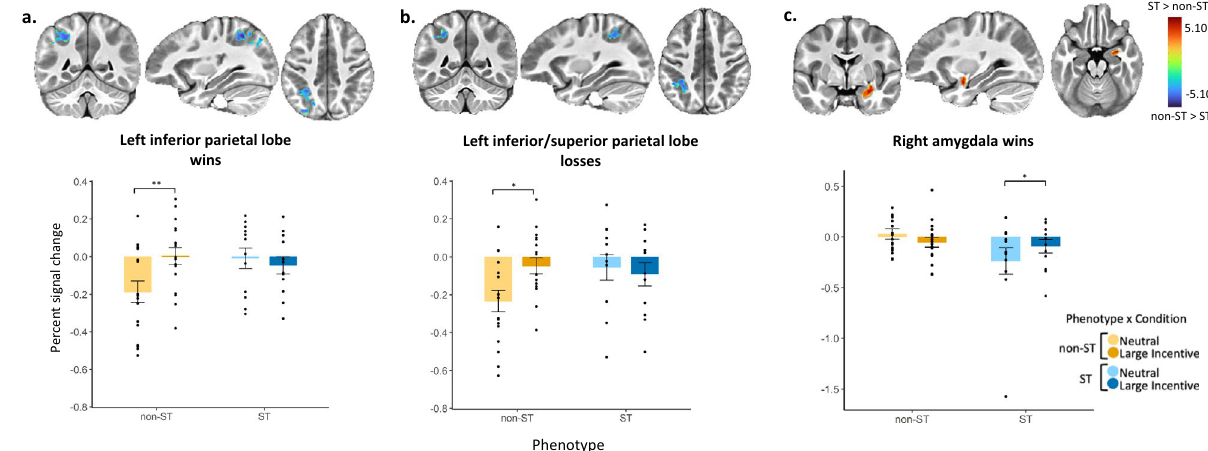
Figure 3. Whole brain voxel-wise fMRI percent BOLD signal change during the Monetary Incentive Delay (MID) task for win and loss anticipation. ST = sign-tracker, non-ST = non-sign-tracker. Participants were presented with an anticipatory cue indicating the upcoming potential gain, no gain, or loss. Results of whole- brain voxelwise linear mixed effects with fixed effects for group, condition, age, and sex, a group (ST, non-ST) by condition (win-neutral or loss-neutral) interaction and a random intercept for subject. Significant clusters reported with a voxelwise p -value threshold of 0.005 and α < 0.05 at the cluster level (N = 11.73 voxels). Estimated marginal means used for post-hoc tests. Brain activation colors represent t -test z -statistics for group differences in percent signal change between respective conditions (win-neutral, loss-neutral). Blue represents negative values and indicates a greater percent signal change for non-ST than ST between neutral and large incentive conditions (win/loss). Red represents positive values that indicate greater percent signal change for STs between neutral and large incentive conditions. Bar graphs depict percent signal change in respective clusters across neutral and large incentive conditions. For non-STs (yellow) and STs (blue), lighter colors indicate neutral trials whereas darker colors indicate win/loss trials. Significant differences derived from post hoc tests are marked with asterisks; p < .01**, p < .05*. Significant contrasts (win-neutral or loss-neutral) correspond with brain images such that blue indicates a significant contrast for non-ST and red indicates a significant contrast for STs. ( a ) Blood oxygen level dependent (BOLD) activations for a group by condition interaction in the left inferior parietal lobe during win anticipation compared to neutral anticipation. ( b ) BOLD activations for a group by condition interaction in the left inferior parietal lobe during loss anticipation compared to neutral anticipation. ( c ) BOLD activations for a group by condition interaction in the right amygdala during win anticipation compared to neutral anticipation. fMRI images derived using AFNI software (Cox, R.W. AFNI: software for analysis and visualization of functional magnetic resonance neuroimages. Computers and Biomedical Research 29, 162–173